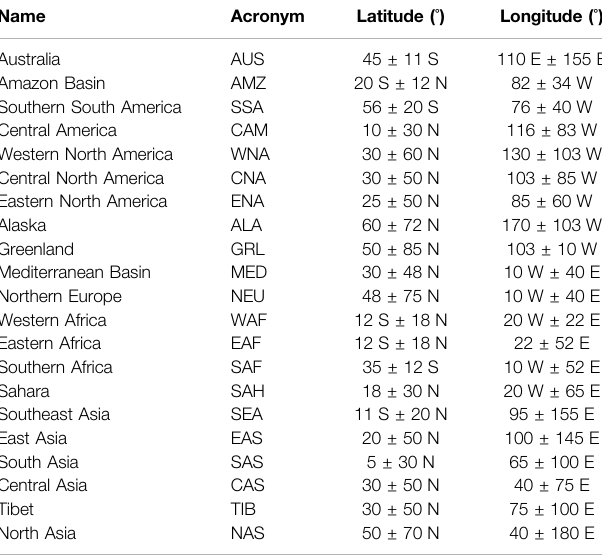
TABLE 3 | List of regions used in this study. Only land grid points are used in the